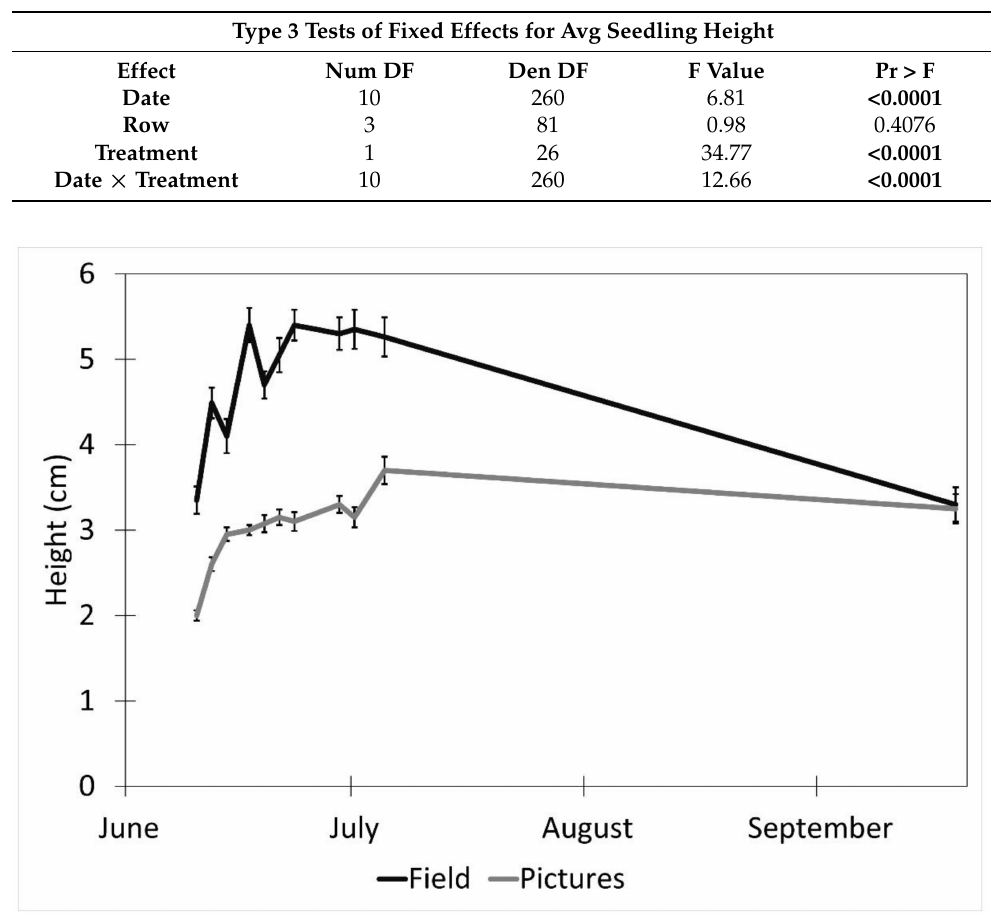
Figure 4. Effect of date on picture height measurements (mean ± SE) estimated from images obtained with remote cameras and actual heights measured in the field every 2–3 days between 10 June and 5 July 2017, and a final measurement on 19 September 2017. Data were collected from study plots located at the Utah Testing Range,